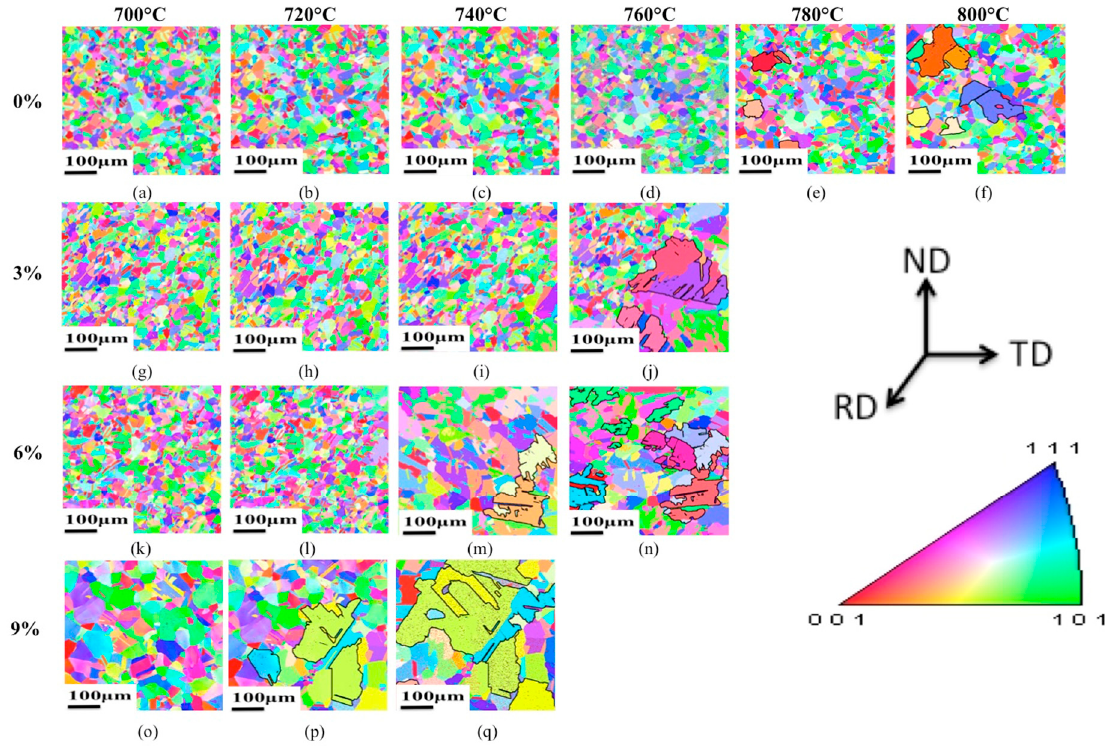
Figure 4. EBSD progression maps for 0% ( a – f ), 3% ( g – j ), 6% ( k – n ), and 9% ( o – q ) induced strain